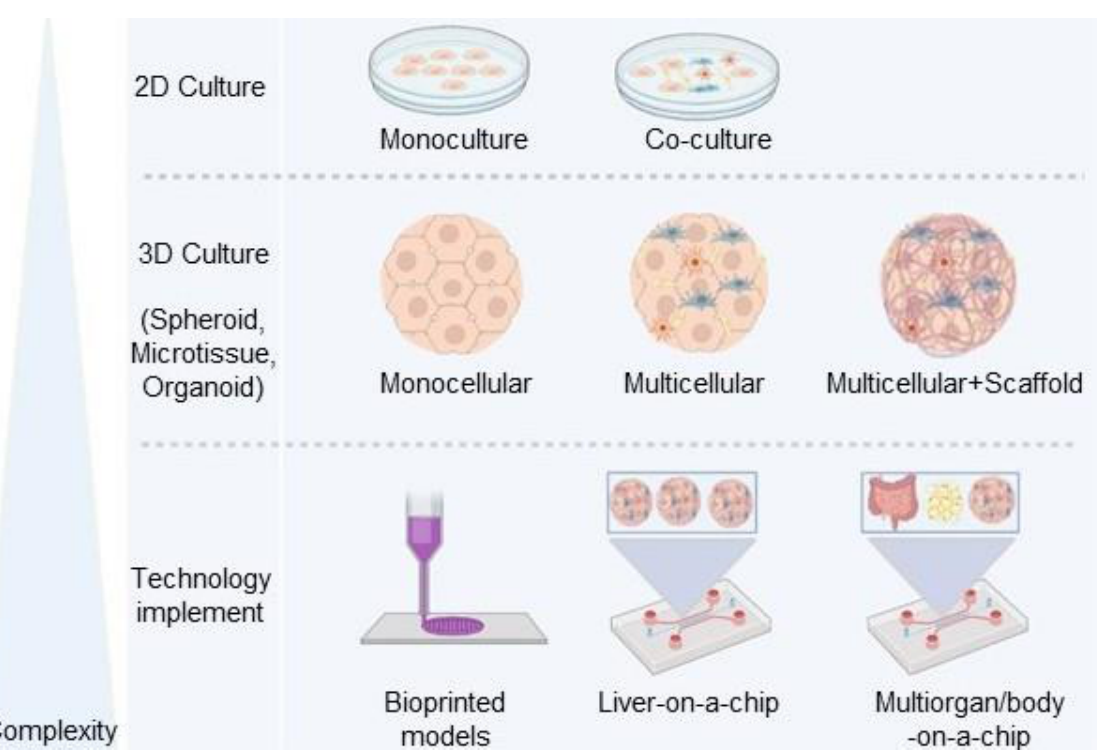
Figure 2: Cell sources, scaffolds, and complexity of in vitro models used in NAFLD study . Since from the simple state of the disease (steatosis) to the more advanced stages (NASH and fibrosis), var- ious cell types and tissues involved, therefore more complex in vitro models are required. The complex- ity of the cellular models started from 2D monoculture, 2D co-culture, 3D monoculture, and 3D co-culture scaffold-free or scaffolded, up to organ-on-a-chip, and multiorgan or body-on-a-chip models. In this ap- proach, various sources of parenchymal and non-parenchymal cells such as primary, stem cell-derived, or immortalized cell lines are available to generate the in vitro liver models. On the other hand, a variety of synthetic and natural scaffolds or a combination of both of them are optional for biomimetic construct generation. Moreover, microfluidic systems could optimize the in vitro condition toward the body’s phys-